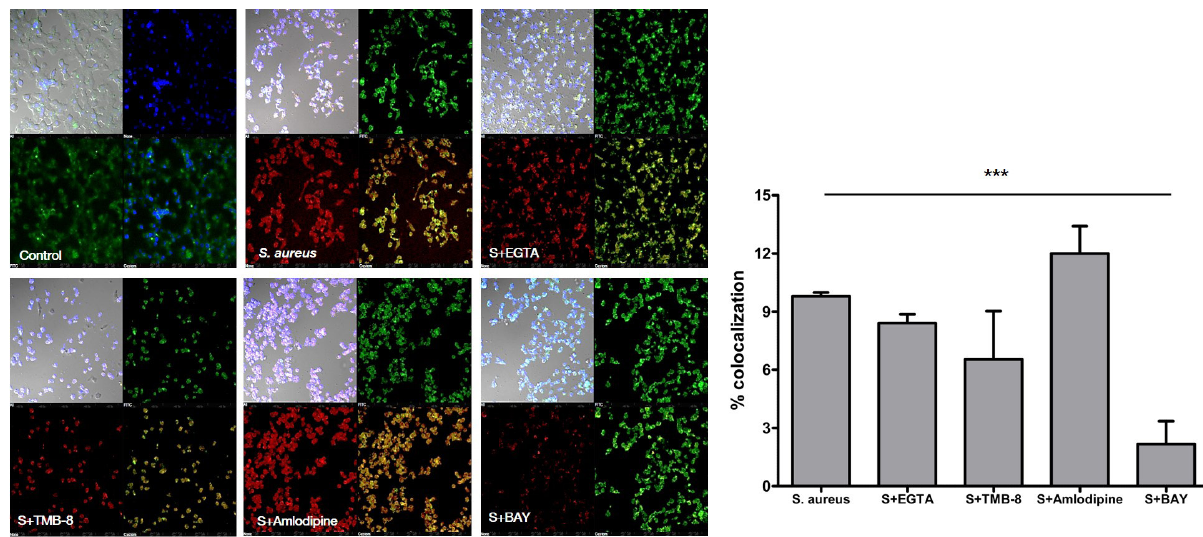
Figure 4: Calcium differentially regulates fusion of phagosomes with lysosomes in macrophages during S. aureus infection. Murine J774 macrophages were incubated with either EGTA or TMB-8 or BAYK8664 or amlodipine for 2h followed by infection with FM4-64 labelled 20 MOI S. aureus infection for 2h. Following incubation cells were washed and processed and stained for Lysotracker green. Cells were fixed with 4% paraformaldehyde and mounted with DAPI. Images were analyzed using confocal microscopy. Confocal imaging was performed with Nikon C2 laser scan confocal microscope with 60x magnification. Merged images with DAPI (blue), S. aureus tagged with FM4-64 (red) and Lysotracker (green) staining are depicted. Bar graphs adjacent to confocal images show Region of Interest (ROI). Data represent mean ± SD of three independent experiments of 10 Fields of each group. P-value between-group S. aureus vs S. aureus + BAYK8664 is